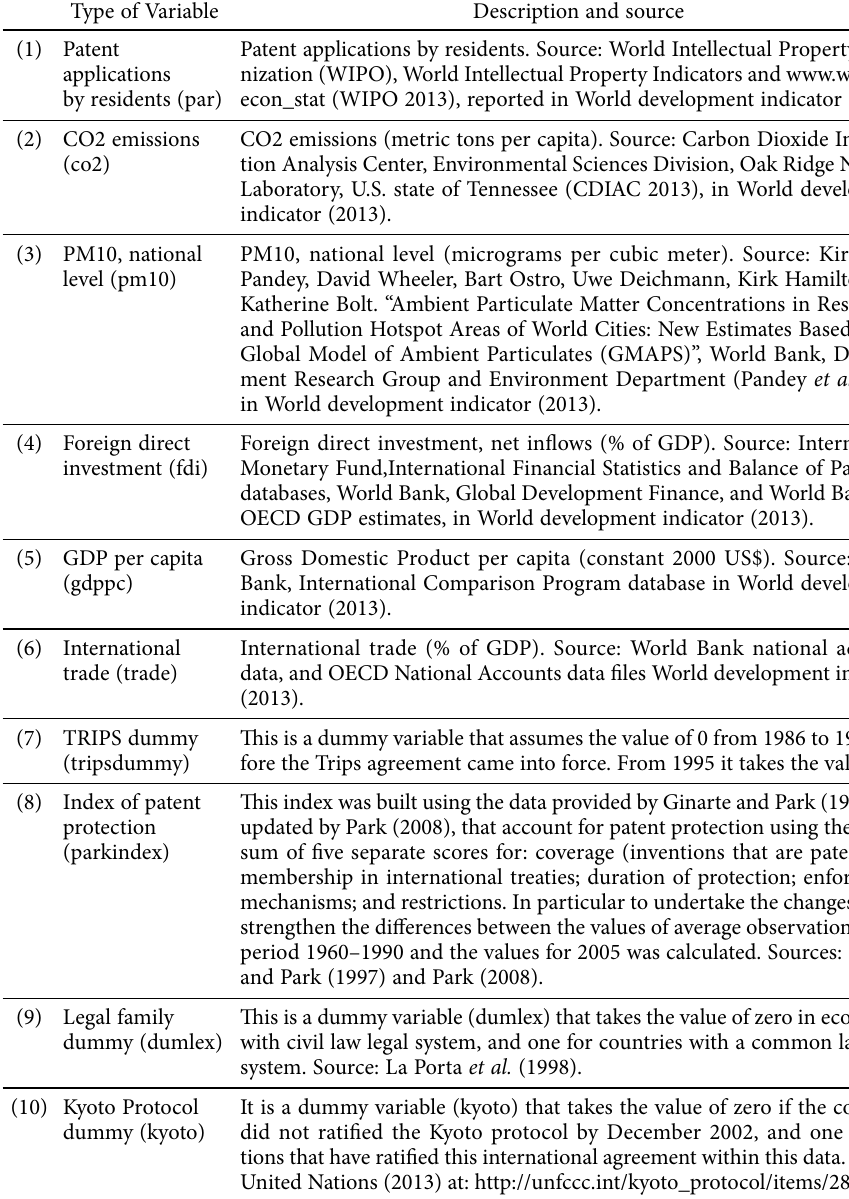
Table 2. Variables and data sources Type of Variable Description and